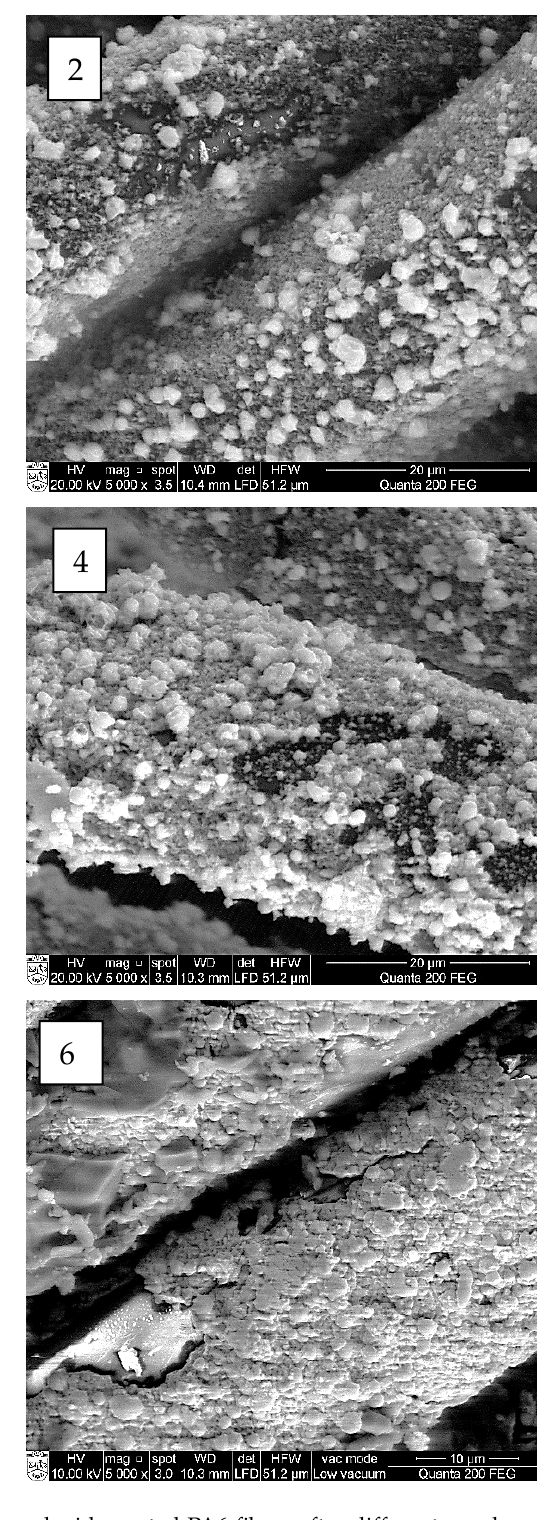
Figure 8. SEM images of copper selenide-coated PA6 fibers after different numbers of treatment cycles: ( 1 ) first (mag. 5000×); ( 2 ) second (mag. 5000×); ( 3 ) third (mag. 5000×); ( 4 ) fourth (mag. 5000×); ( 5 ) fifth (mag. 5000×); and ( 6 ) sixth (mag. 5000×).